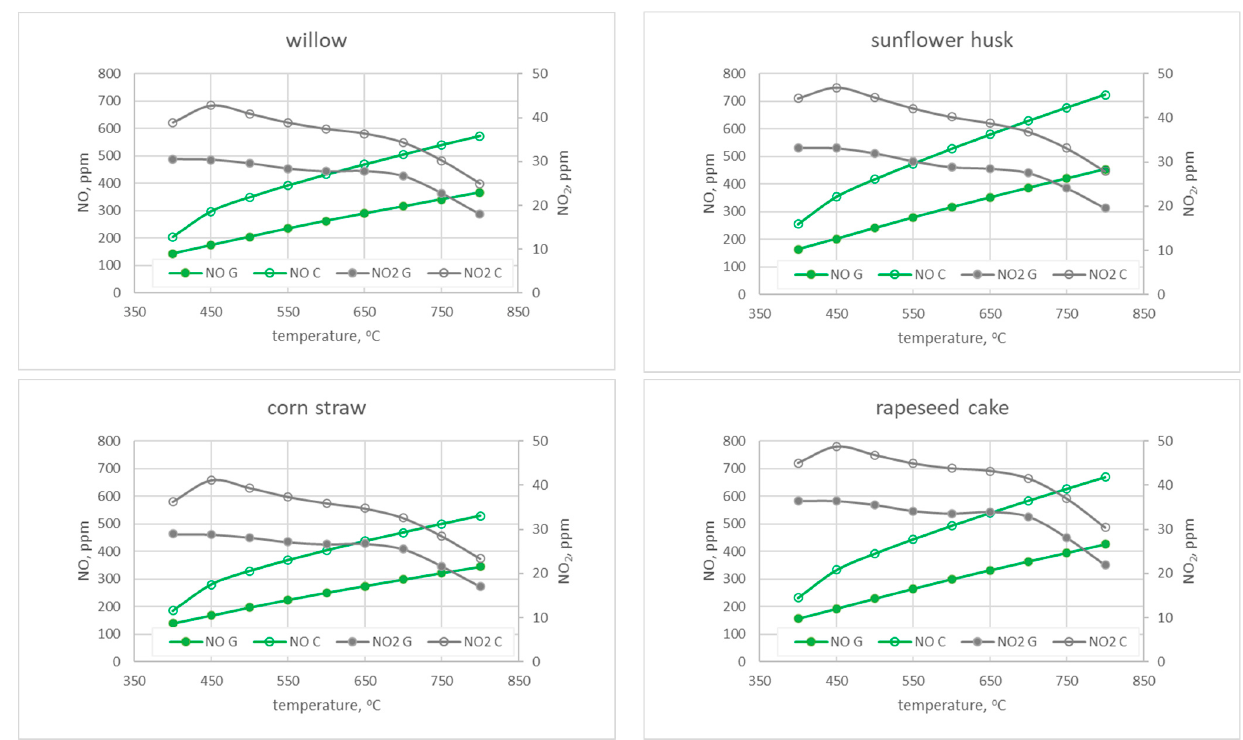
Figure 6. The dependence of NO and NO 2 shares as a function of temperature for the residence time of 60 s. of 60